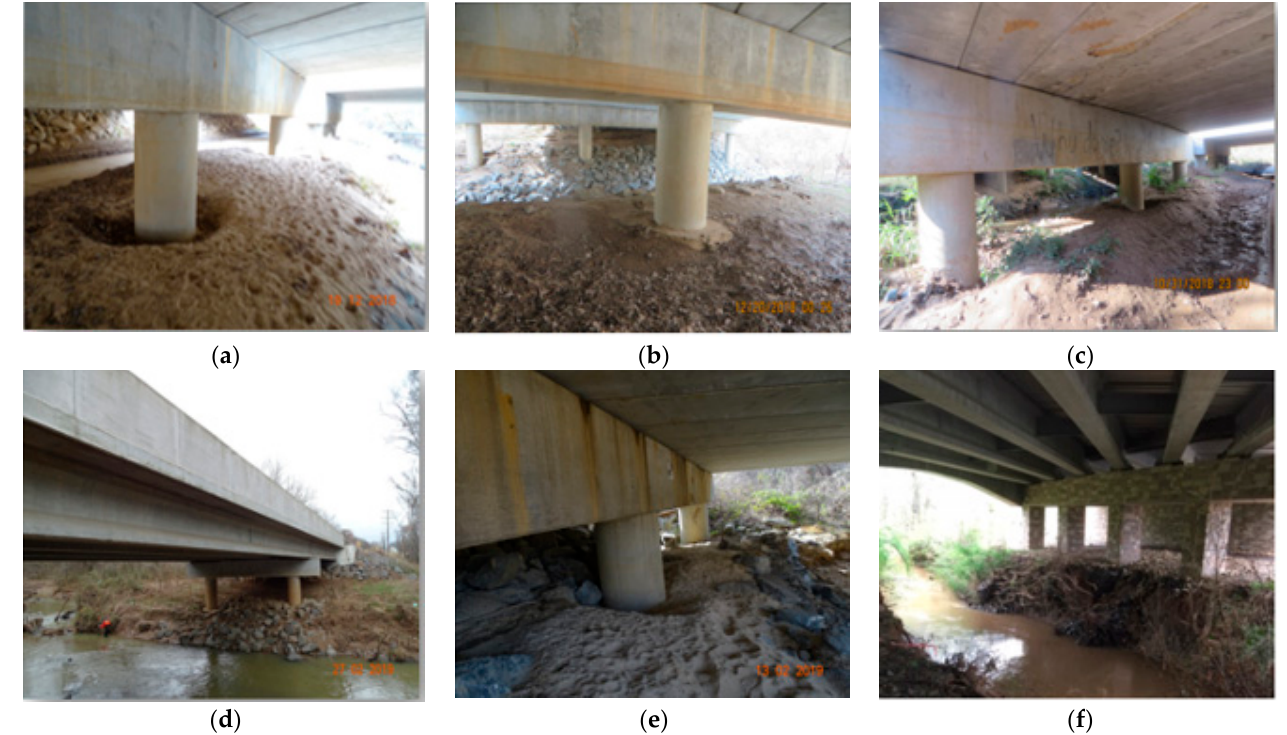
Figure 1. Examples of bridges with piers-on-bank and experiencing scour ( a ) Rocky River; ( b ) Mallard Creek; ( c ) Pharr mill; ( d ) Blackwood Creek; ( e ) Rankin Lake; ( f ) Toby